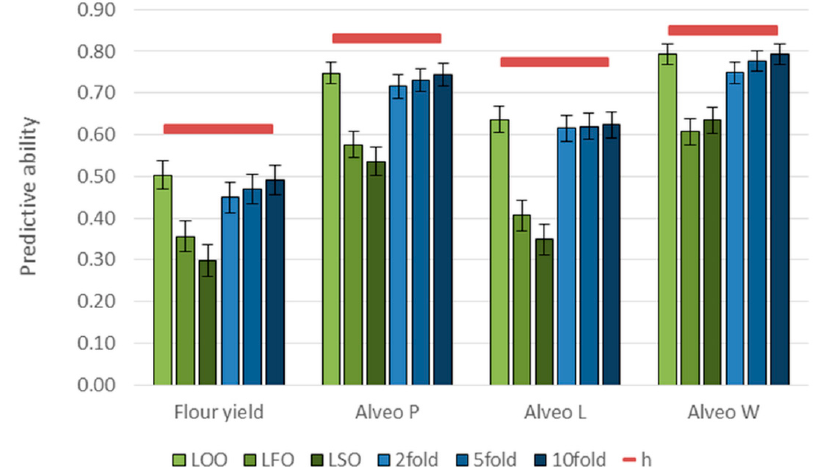
Figure 5. Predictive abilities for each quality trait based on GBLUP models. Red lines are the square root of narrow-sense genomic heritabilities (h) for each trait. Cross-validation (CV) strategies: LOO= leave-one-out, LFO= leave-family-out, LSO= leave-set-out, and k-fold= 2-, 5-, and 10-fold. Table 6. Regressions of corrected phenotypes on genomic estimated breeding values (GEBVs) based on different cross-validation strategies using the GBLUP models. Bias is the deviation from the expected regression of 1.0.